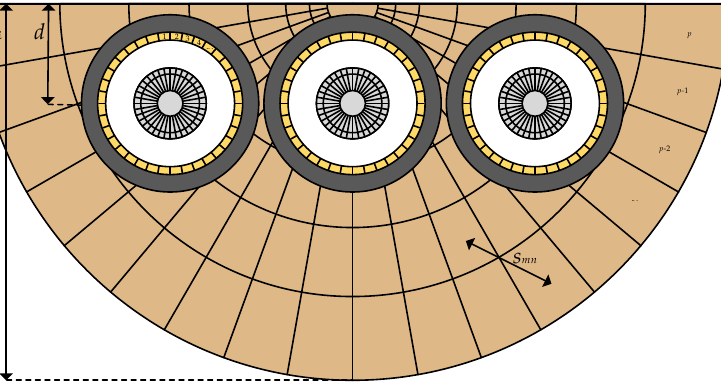
Figure A1. Segmentation of conductors and earth using the partial conductor